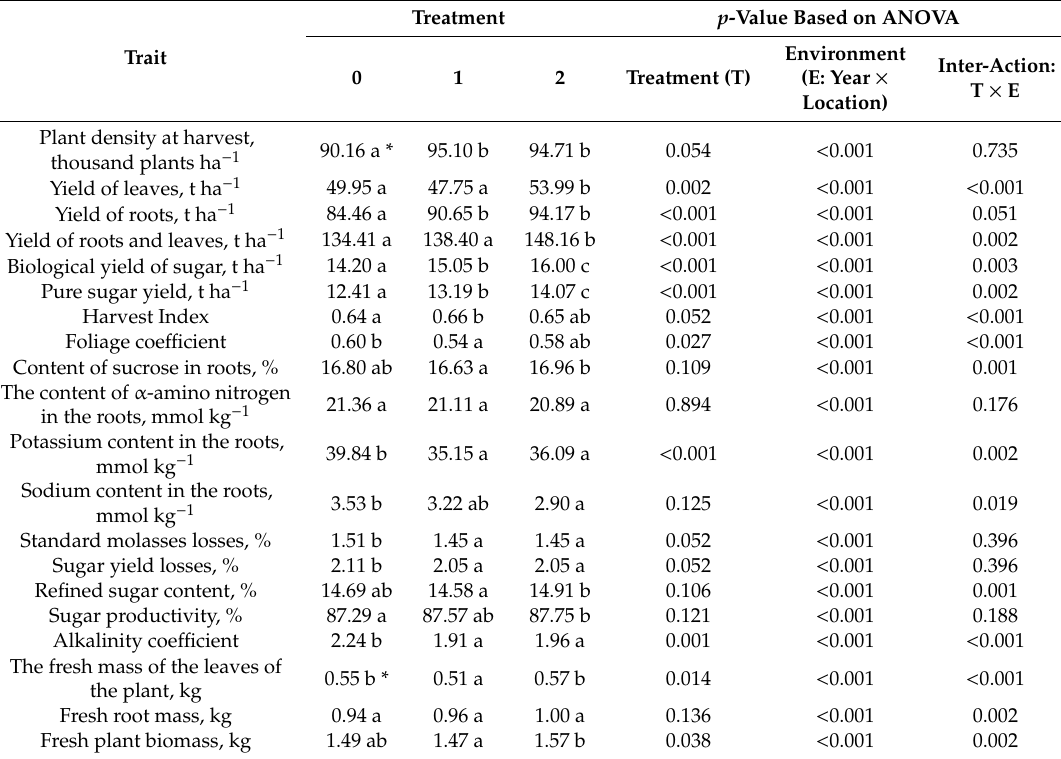
Table 5. The influence of Penergetic activators (Penergetic International AG, Romanshorn, Switzerland) and Azoter bacterial preparation (Azoter Trading, Bratislava, Slovakia) on the yield, the technological quality of the roots and traits of sugar beet plants (2017–2019), and the e ff ects of treatment, environment (location × year), and their